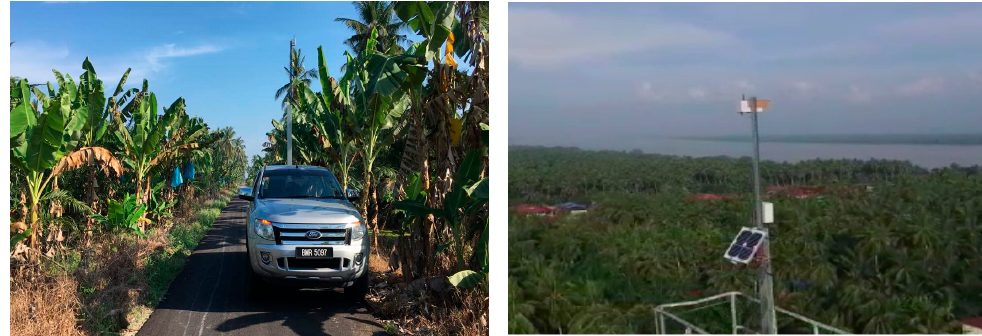
Figure 12. Dense growth of Coconut trees around the mangrove forest, which fall in the first order Fresnel zone.